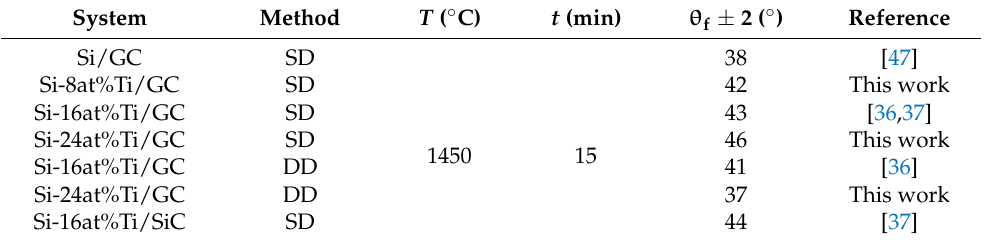
Table 1. Equilibrium contact angle values ( θ f ) measured for the liquid Si-rich Si-Ti alloys in contact with GC and SiC at T = 1450 ◦ C under an Ar atmosphere by the sessile drop (SD) and dispensed drop (DD)